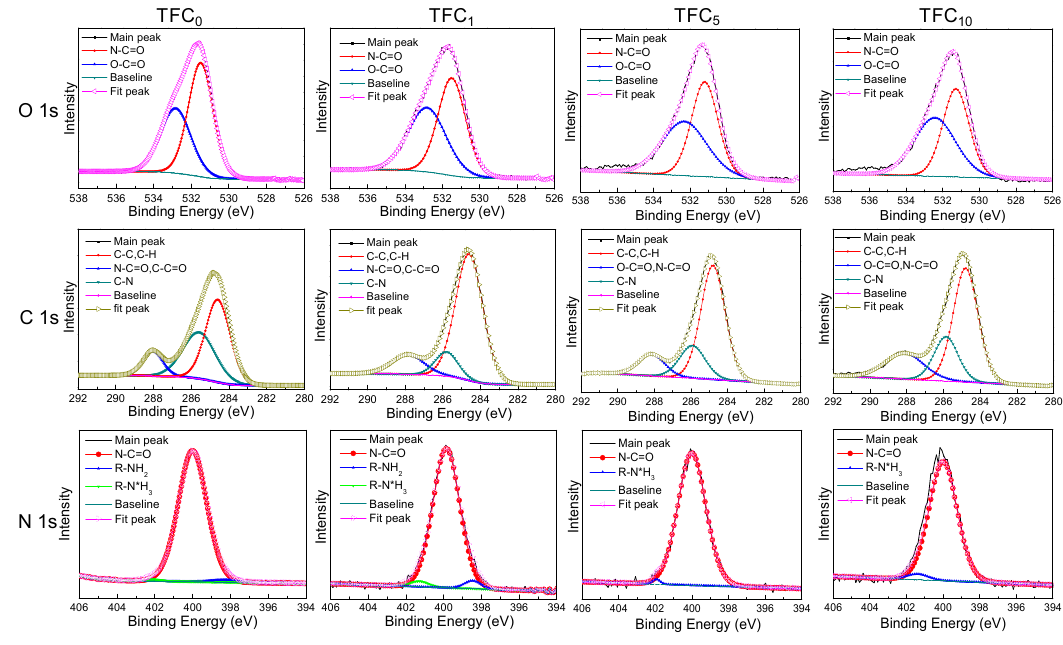
Figure 6. High-resolution XPS spectra of TFC membranes.